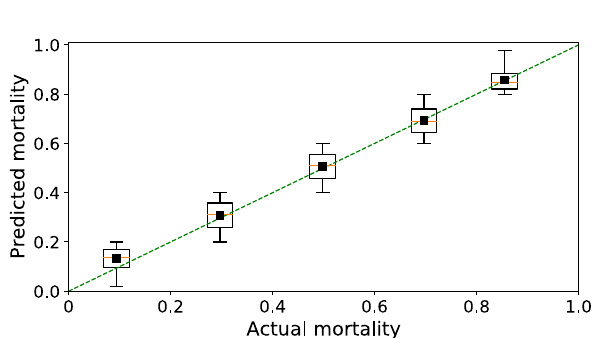
Figure 3. Model calibration. The calibration analysis shows that mortality predicted by the XCOVID-BR model performs uniformly across bins of